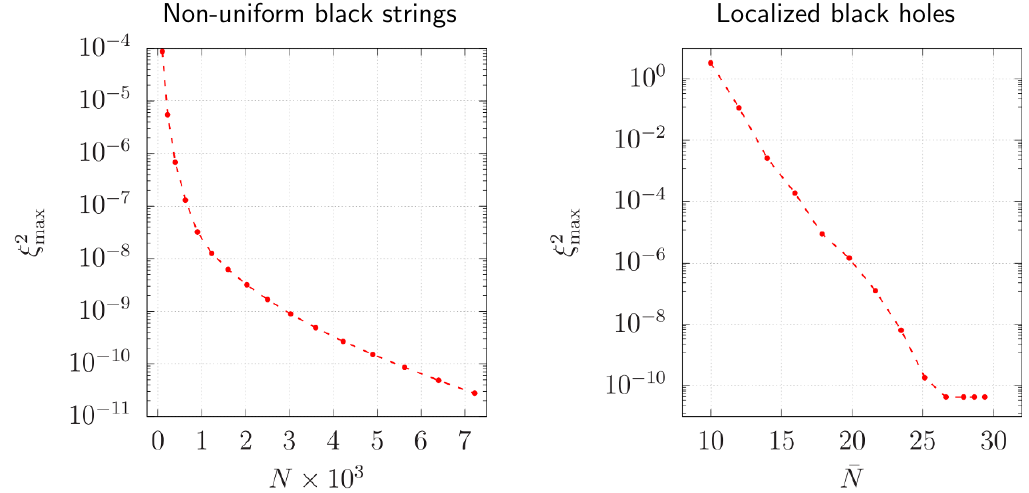
Figure 14 . Logarithmic plot of (cid:24) 2 = max[ (cid:24) 2 ] as a function of the grid size. In both cases, the max error decays exponentially, as